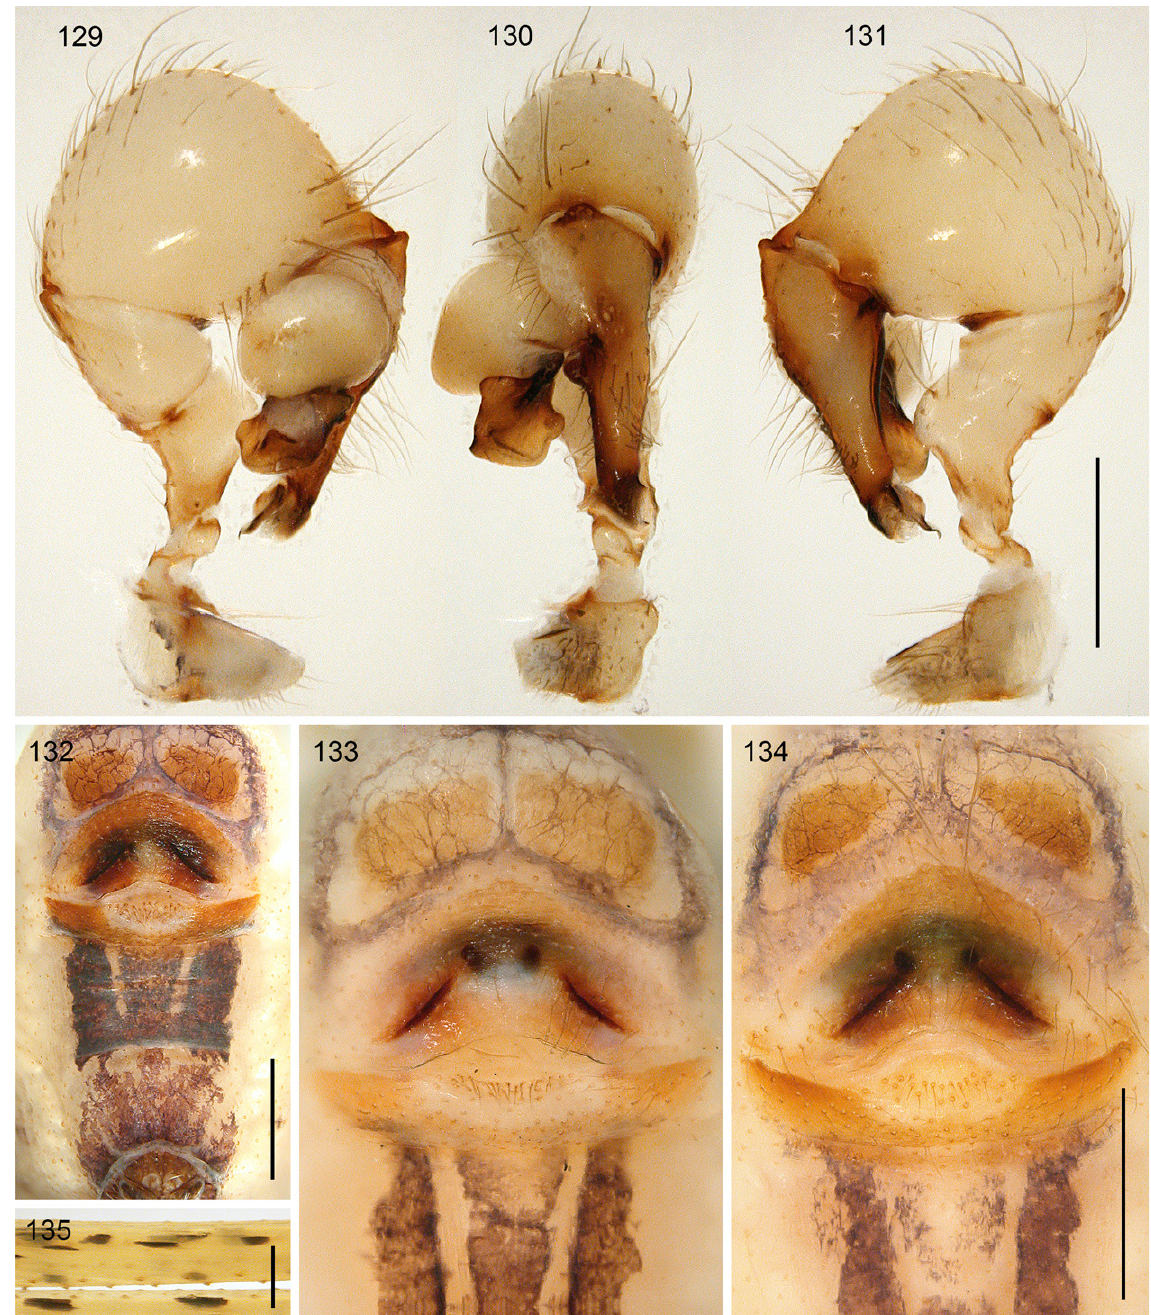
Figs 129–135. Holocnemus hispanicus Wiehle, 1933. 129–131 . Male from Spain, Cáceres, Conquista de la Sierra (CRB); left palp, prolateral, dorsal, and retrolateral views. 132 . Female from Spain, Málaga, Ronda (CRB); abdomen, ventral view. 133 . Female from Spain, Granada, “Sierra Havana” (SMF 8802); epigynum, ventral view. 134 . Female from Spain, Málaga, between Periana and Ventas Zafarrayas (ZFMK Ar 23862); epigynum, ventral view. 135 . Female from Spain, Badajoz, SW of Zafra (CRB); detail of female left femora 3 and 4, retrolateral-ventral view. Scale bars: 129–134 = 0.5 mm; 135 = 0.2